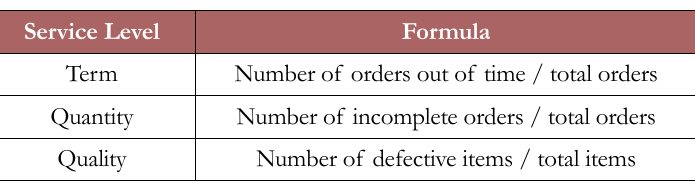
Table 1. Service level